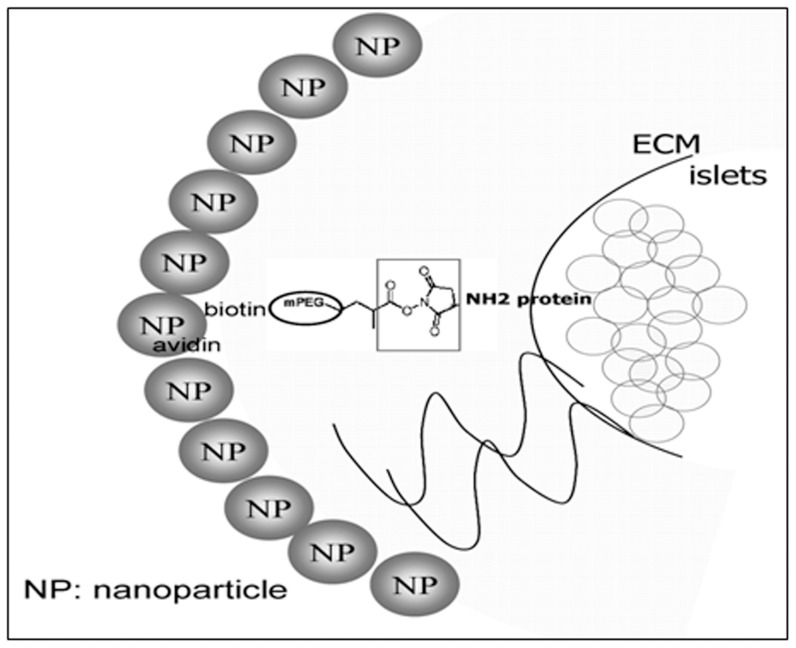
Schematic model of nanoparticles binding to pegylated islet.Avidin groups on the nanoparticle surface mediate nanoparticle attachment to biotinylated PEG that coats the islet.